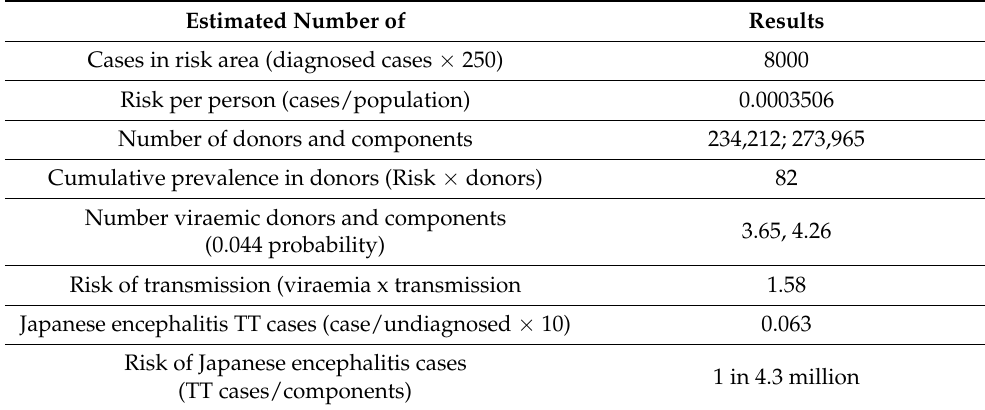
Table 1. Estimate of number of symptomatic cases of Japanese encephalitis secondary to blood